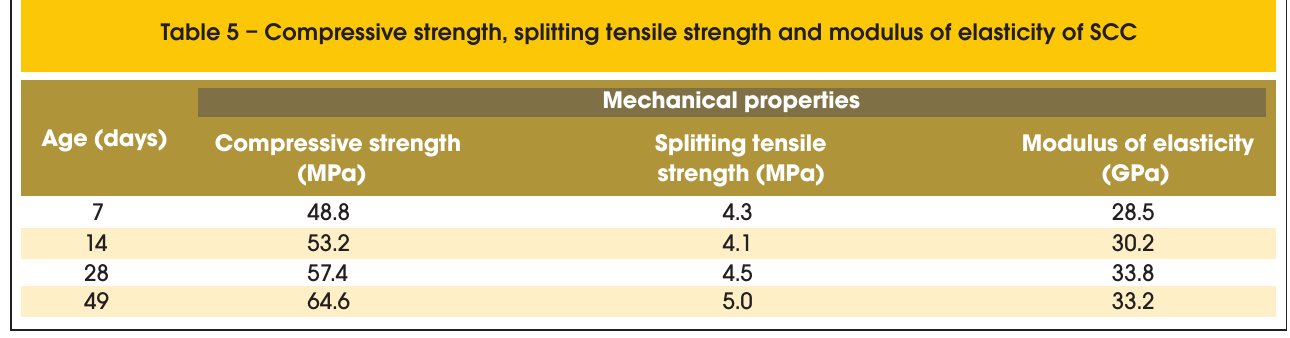
Table 5 – Compressive strength, splitting tensile strength and modulus of elasticity of SCC